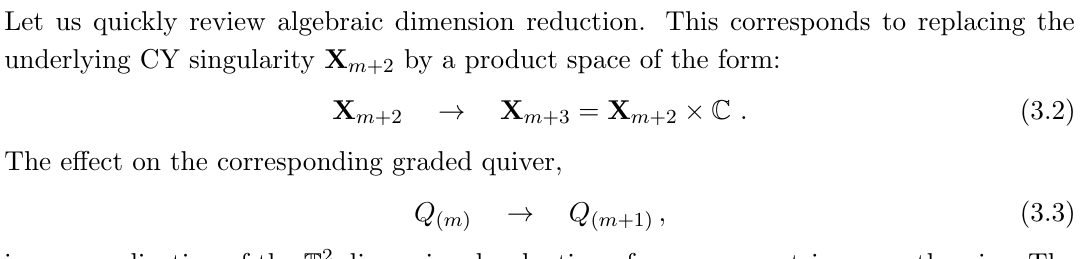
Figure 2 . Toric diagrams for F ( m )